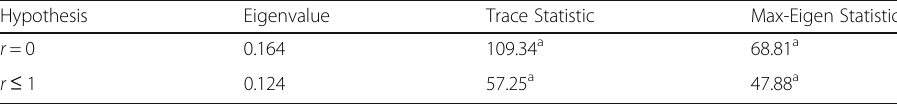
Table 6 Johansen Cointegration Test for ACE Transformed Variables Hypothesis